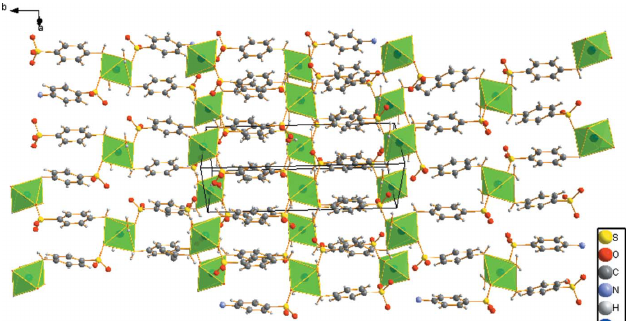
Figure 3 Polymeric layers formed by interconection of neighbouring cobalt(II) cations.